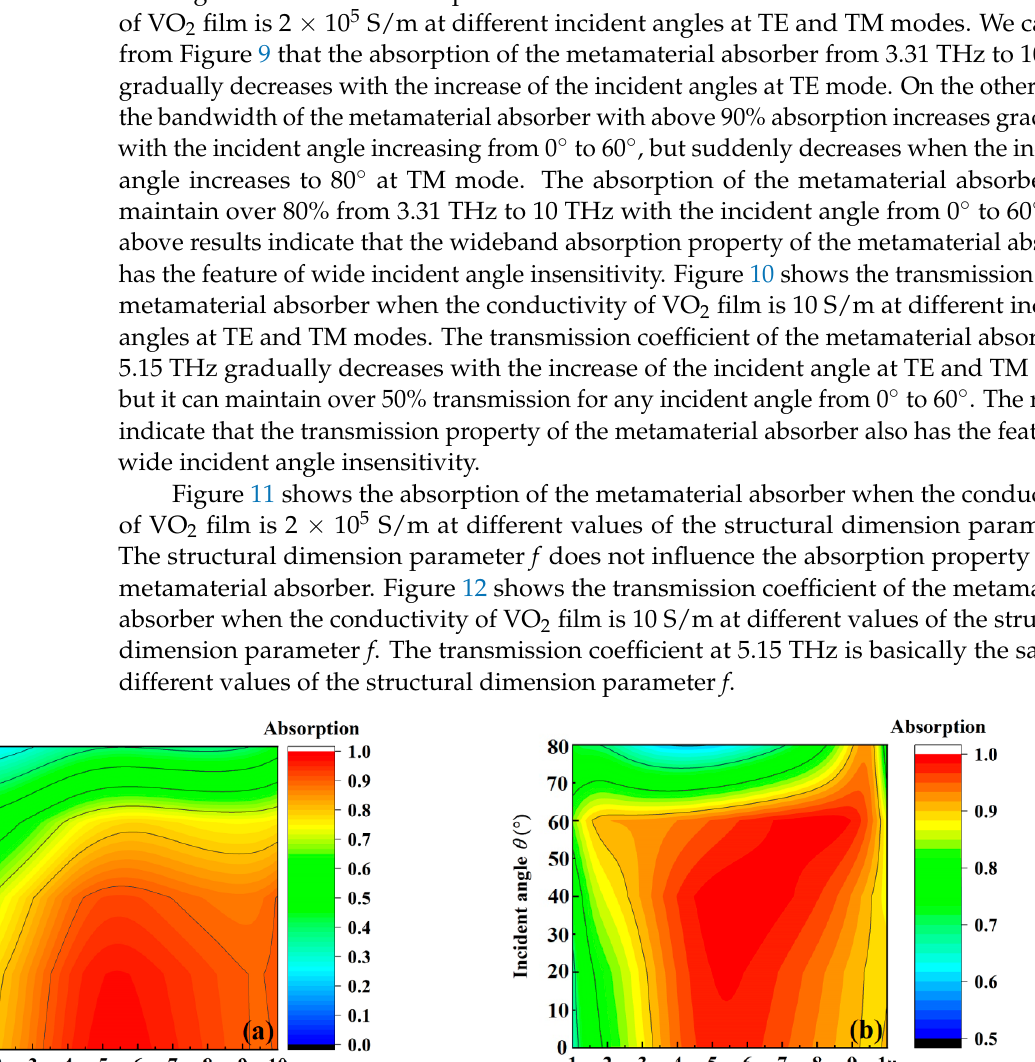
Figure 8. The transmission property of the metamaterial absorber when the conductivity of VO 2 film is 10 S/m at different polarization angles.